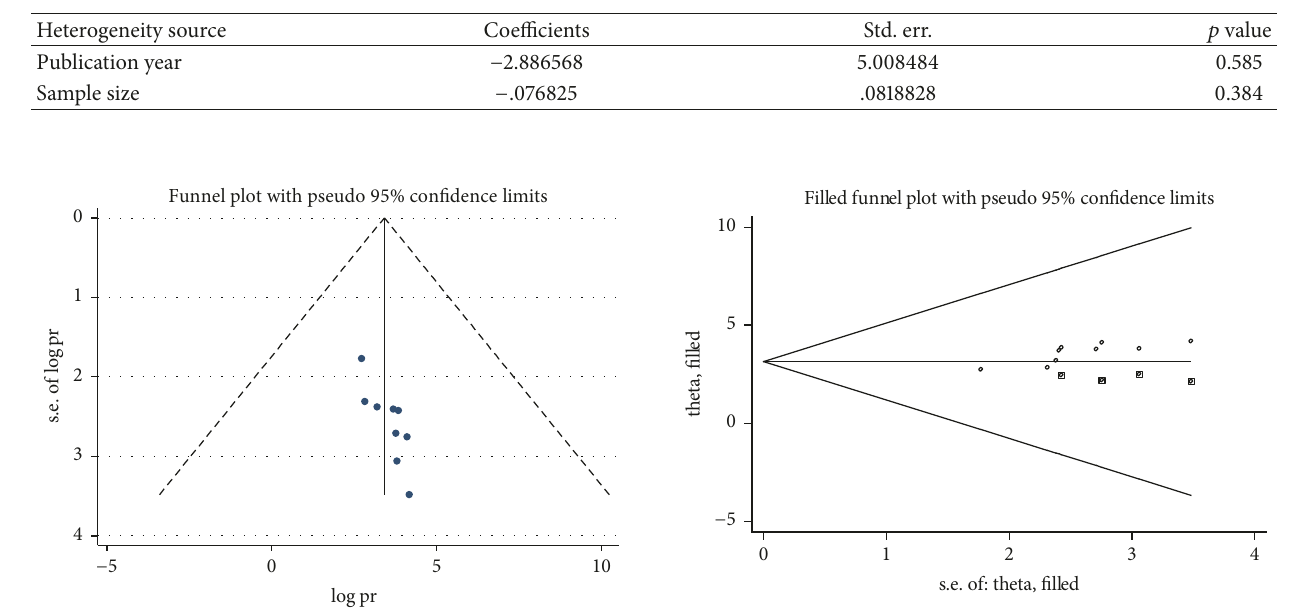
Figure 4: Funnel plots to test the publication bias of the 9 studies, 2018.